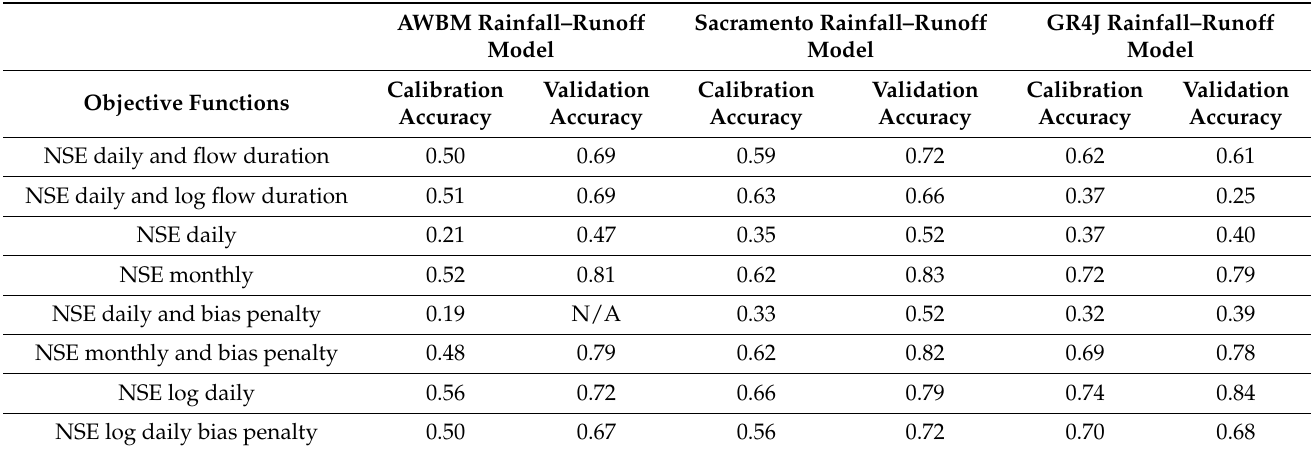
Table 3. The comparison of the three models, GR4J, AWBM and Sacramento, for the calibration and validation accuracy values.